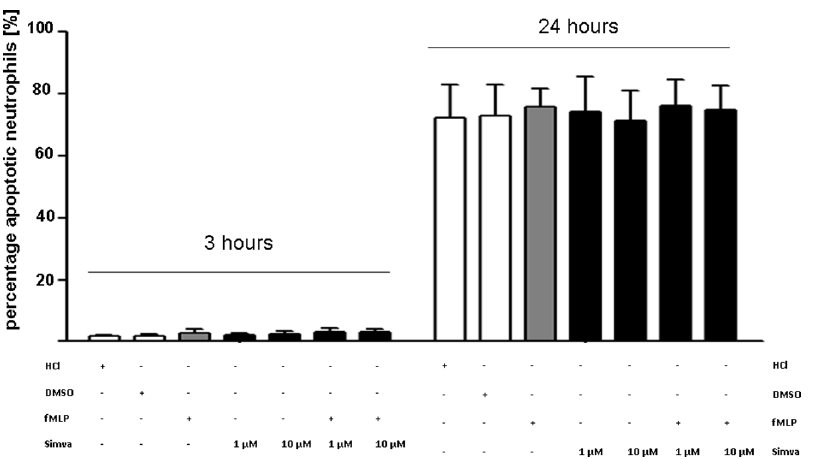
Figure 7. Simvastatin does not affect neutrophil apoptosis. Apoptosis of neutrophis in presence or absence of simvastatin was measured using Annexin V with flow cytometry after 3h and 24 hours respectively (n=6; repetition=3). Statistical significance was tested using one way ANOVA with Newman-Keuls Multiple Comparison test. * indicates significant difference to the control group without neutrophils.